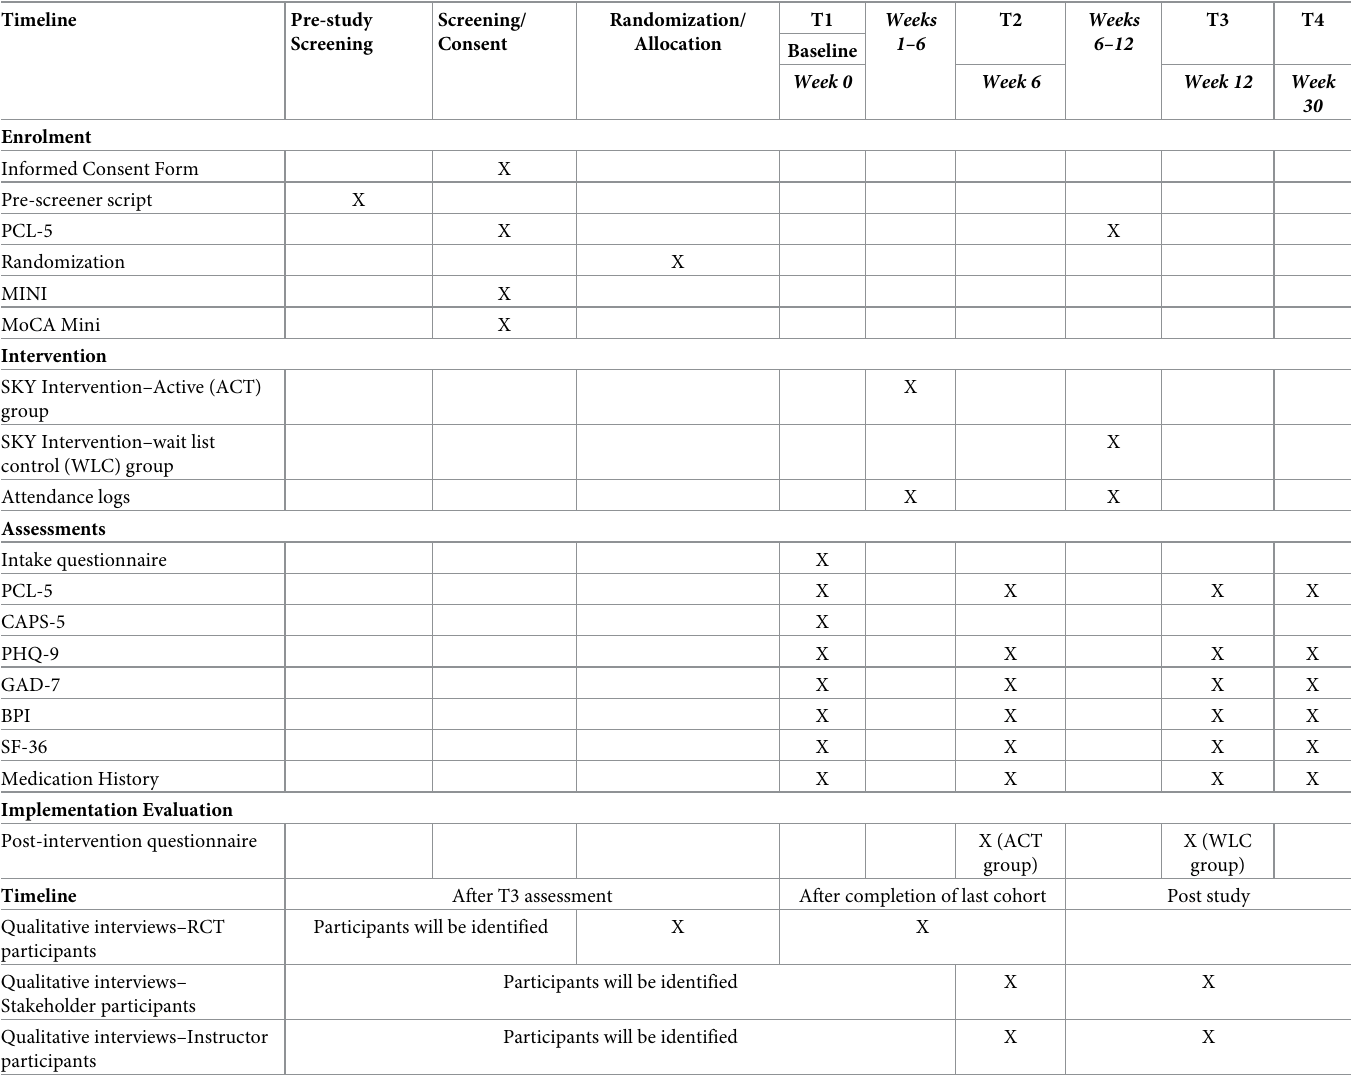
Table 1. Outline of enrolment, study intervention, and effectiveness and implementation